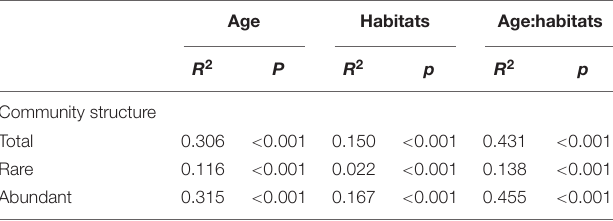
TABLE 1 | Quantitative effects of sampling time and habitats on variation in community composition using non-parametric permutational multivariate analysis of variance (perMANOVA) with adonis function.